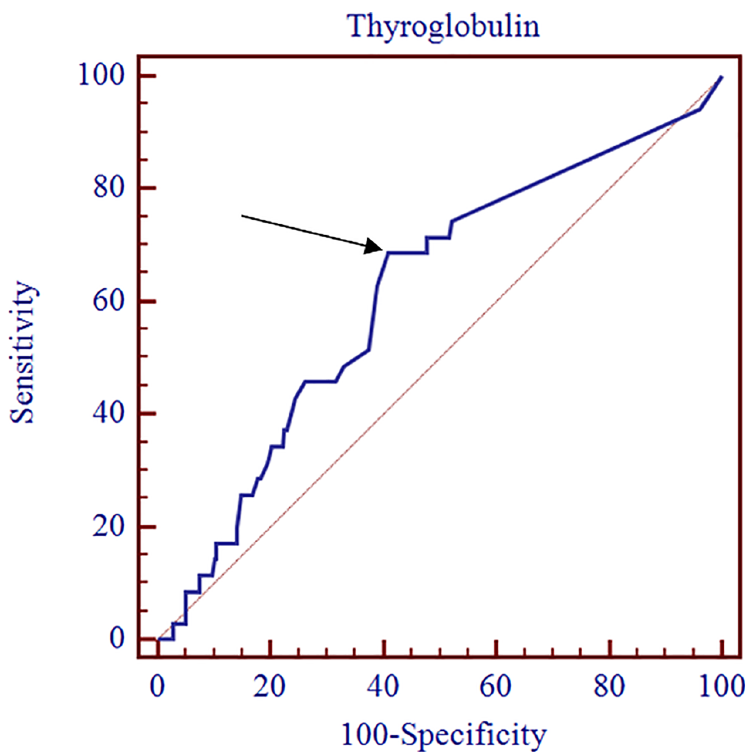
Fig 3. Receiver-operating-characteristics (ROC) curve analysis for preablation TSH-stimulated serum thyroglobulin level of RAI avid metastatic lymph node on SPECT/CT in low- or intermediate-risk group. The optimal cut-off value of TSH-stimulated serum Tg was 0.5 ng/ml for predicting residual RAI avid mLN (sensitivity, 68.6%; specificity, 61.1%; area under the curve, 0.615; p = 0.022).